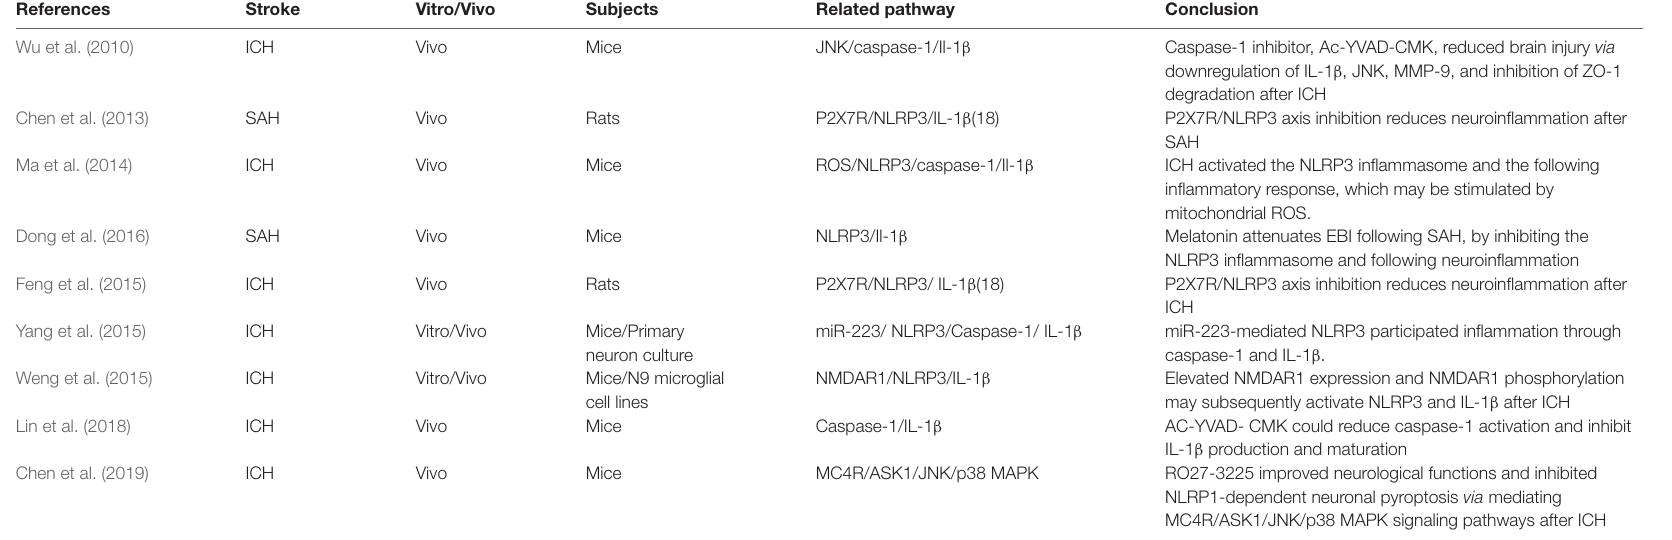
TABLE 3 | Latest research of pyroptosis in hemorrhagic